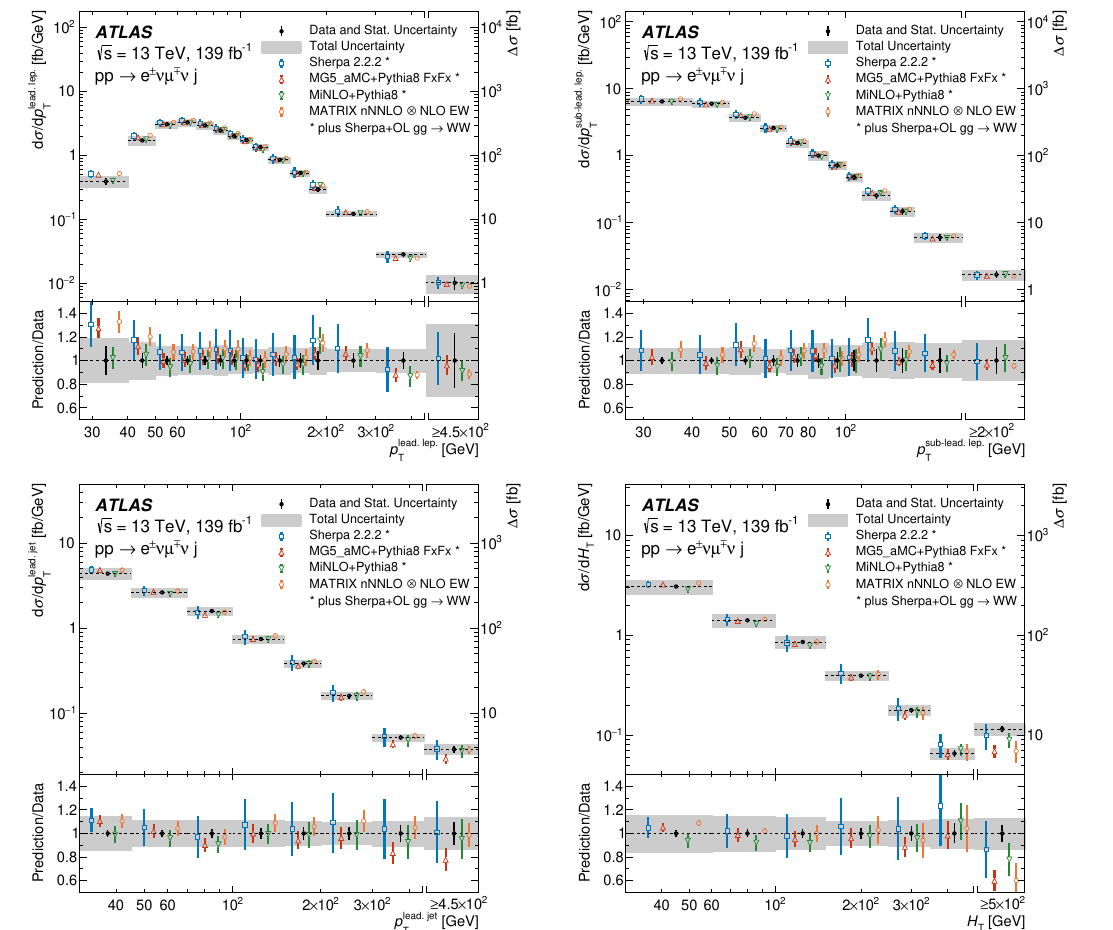
Figure 6 . Measured fiducial cross-sections of WW +jets production for (from left to right and top to bottom): p lead. lep. , p sub-lead. lep. , p lead. jet , and H . The last bin of each distribution is inclusive T T T T in the measured observable and the corresponding integrated cross-section is indicated by the right- hand-side axis. The measured cross-section values are shown as points with error bars giving the statistical uncertainty and solid bands indicating the size of the total uncertainty. The results are compared with the NNLO prediction with extra NLO EW corrections and NLO corrections for gg → WW production (denoted MATRIX ⊗ NLO EW) as well as NLO+PS predictions from + Pythia 8 for q ¯ q initial states, combined with Sherpa + OpenLoops (LO+PS) for the gg initial state. The Sherpa 2.2.2 + OpenLoops prediction is normalized to the total cross-section calculated at NLO in QCD. Theoretical predictions are indicated as markers with vertical lines denoting PDF and scale